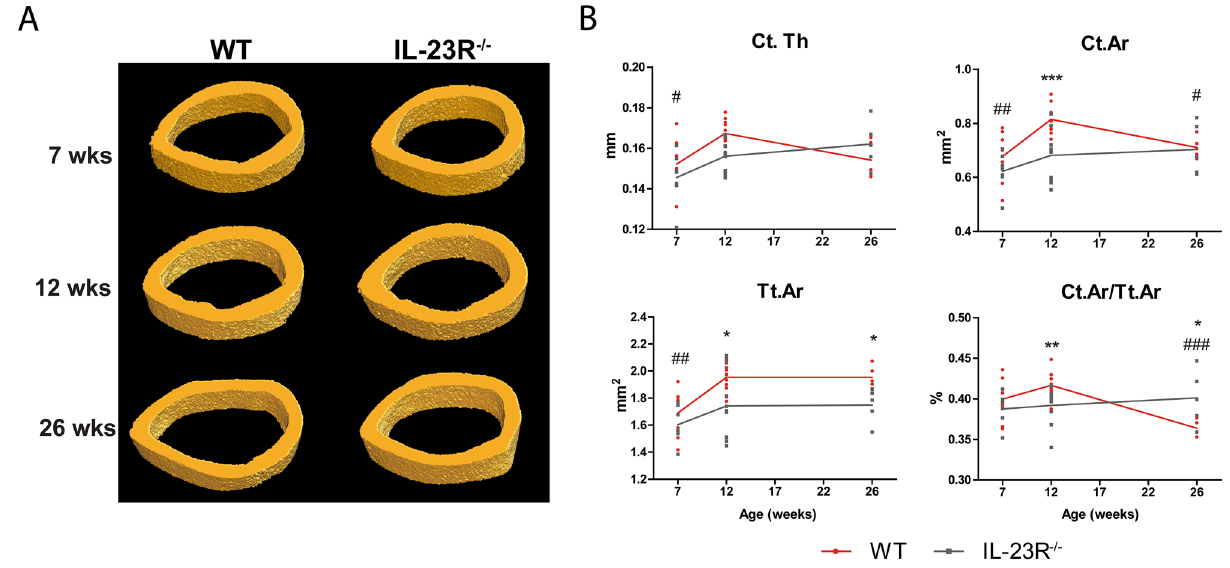
Figure 2. 12-week-old IL-23R deficient mice have lower cortical bone mass compared to WT. Femurs of 7-, 12- and 26-week-old WT and IL-23R −/− mice were used for μCT analysis ( A ) Representative images of µCT analysis of cortical bone. ( B ) Cortical bone mass parameters. Ct.Th average cortical thickness, Ct.Ar cortical bone area, Tt.Ar total cross-sectional area inside the periosteal envelope, Ct.Ar/Tt.Ar cortical area fraction. Pooled data